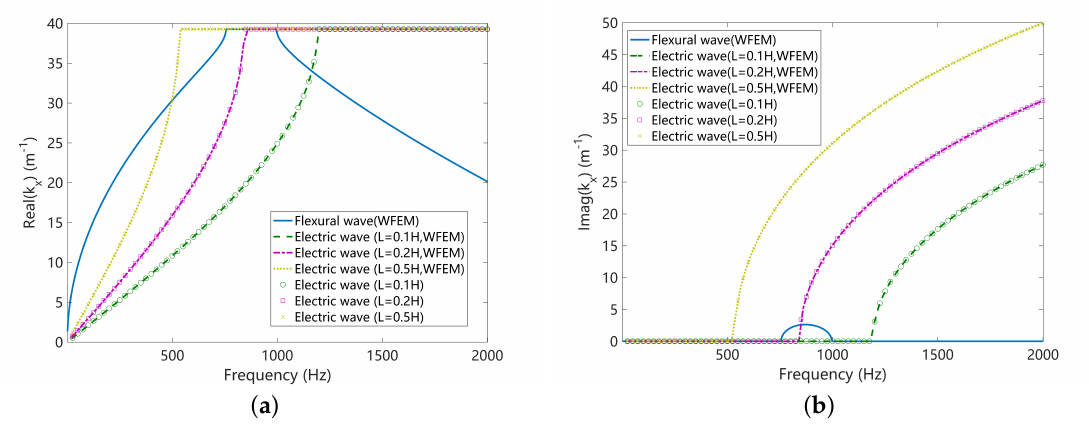
Figure 5. The dispersion curves of the uncoupled disconnected systems: ( a ) real part of the wavenumber; ( b ) imaginary part of the wavenumber. The numerical results obtained by WFEM are validated against the theoretical solutions enclosed in Appendix C for the electric